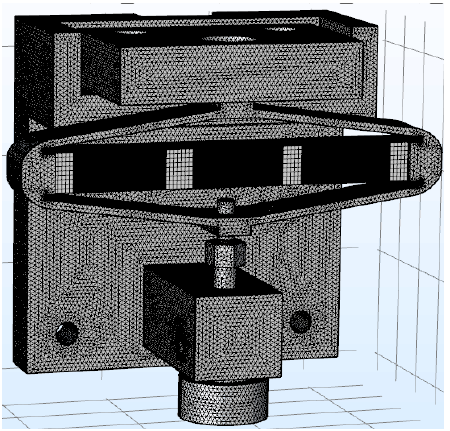
Figure 13. Mesh of the piezo jet dispenser with a diamond amplifier.